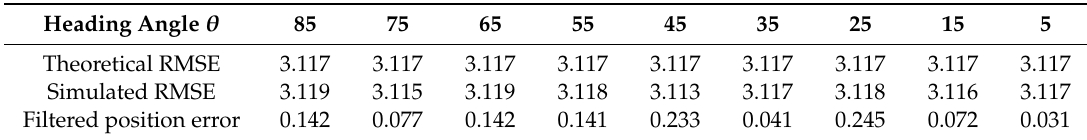
Table 3. Positioning results of Scenario 3.